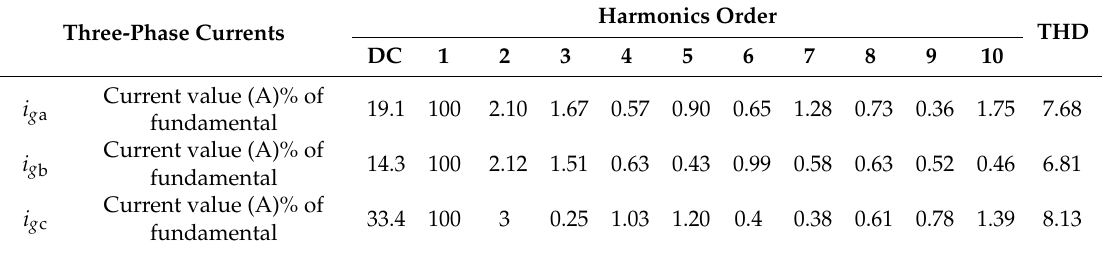
Table 3. Harmonics and THD of the three-phase currents without the dc component suppression. Three-Phase Currents